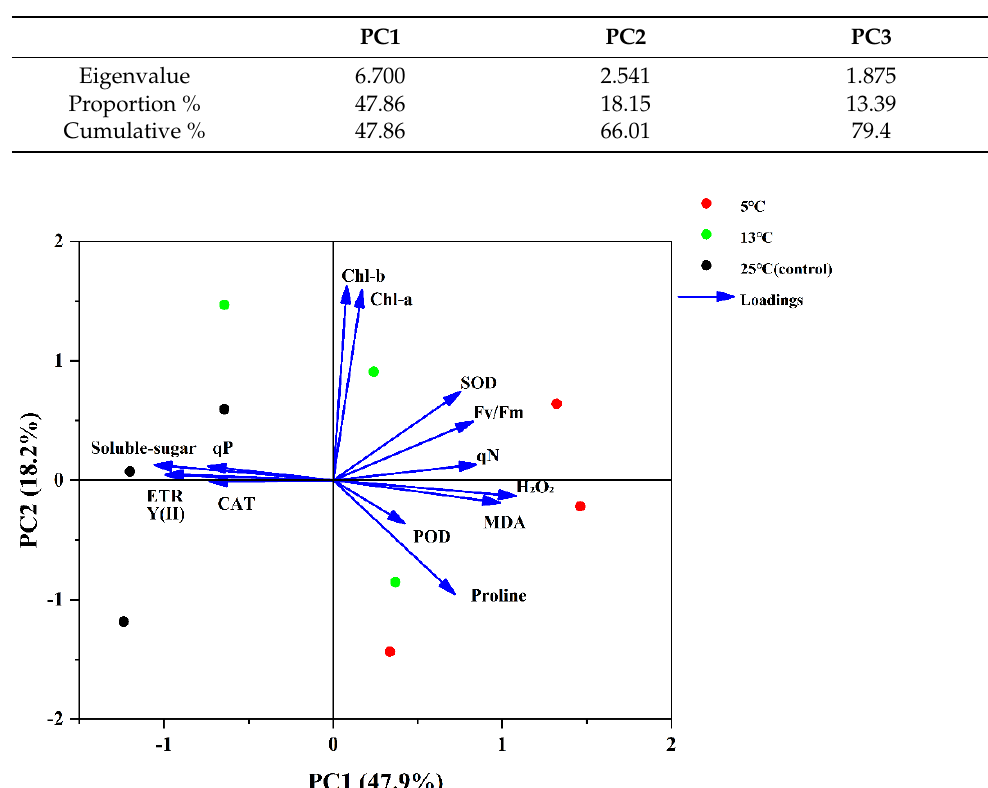
Figure 5. Principal component analysis biplot for PC1 and PC2. MDA, malondialdehyde activity; H2O2, hydrogen peroxide; POD, peroxidase; CAT, catalase; SOD, superoxide dismutase; Chl a , chlorophyll a; Chl b , chlorophyll b; Fv/Fm, ratio of variable and maximal fluorescence; Y( Ⅱ ), effec- tive quantum yield of photosystem Ⅱ ; ETR, electron transport rate; qP, photochemical quenching coefficient; qN, non-photochemical quenching coefficient.